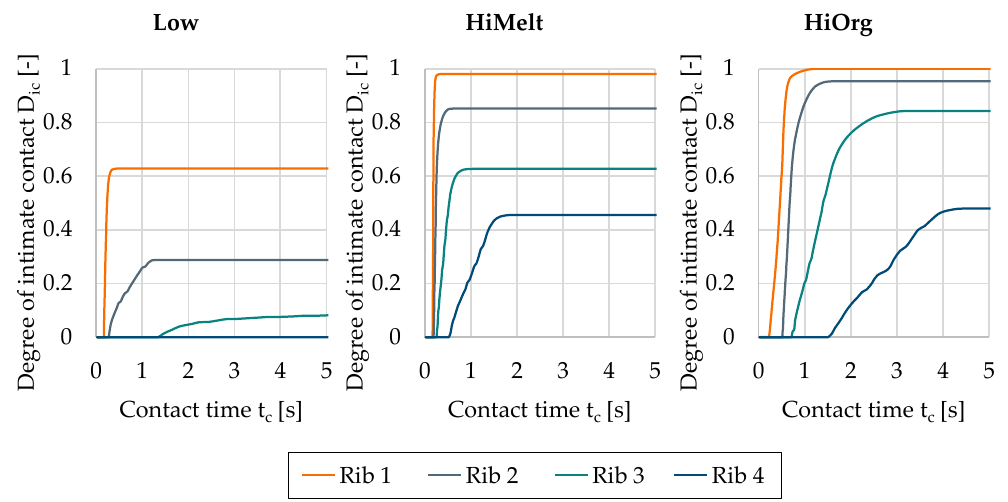
Figure 13. Degree of intimate contact vs. contact time for the individual ribs depending on low process temperatures (“Low”), a high melt temperature “HiMelt”, and a high organo sheet temperature “HiOrg” (cf. Table 1). Depending on the flow path, the degree of intimate contact decreases with increasing distance of the rib from the injection location. As the flow path increases, the pressure supply from the injection location decreases. For set “Low”, the melt cools down before it covers the fourth rib, resulting in D ic = 0. By increasing the melt temperature (“HiMelt”), the intimate contact is promoted, because a complete covering of all rib interfaces